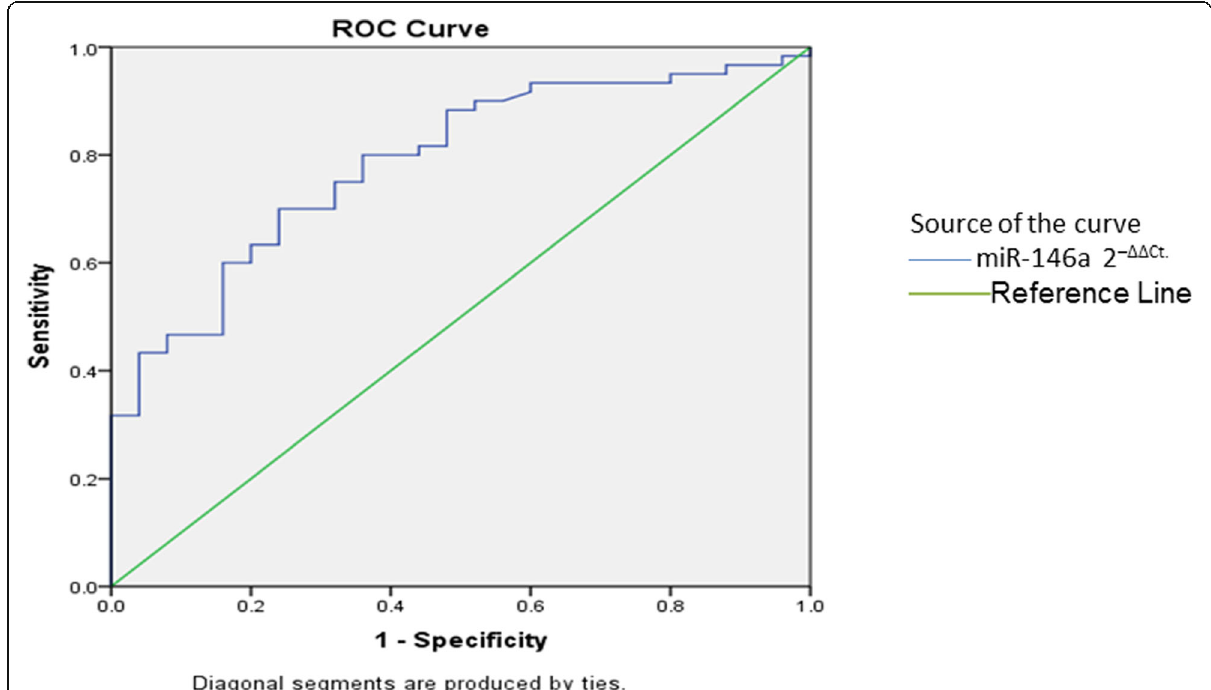
Fig. 2 ROC curve analysis showing the AUC of miR-146a in patients with BD versus controls